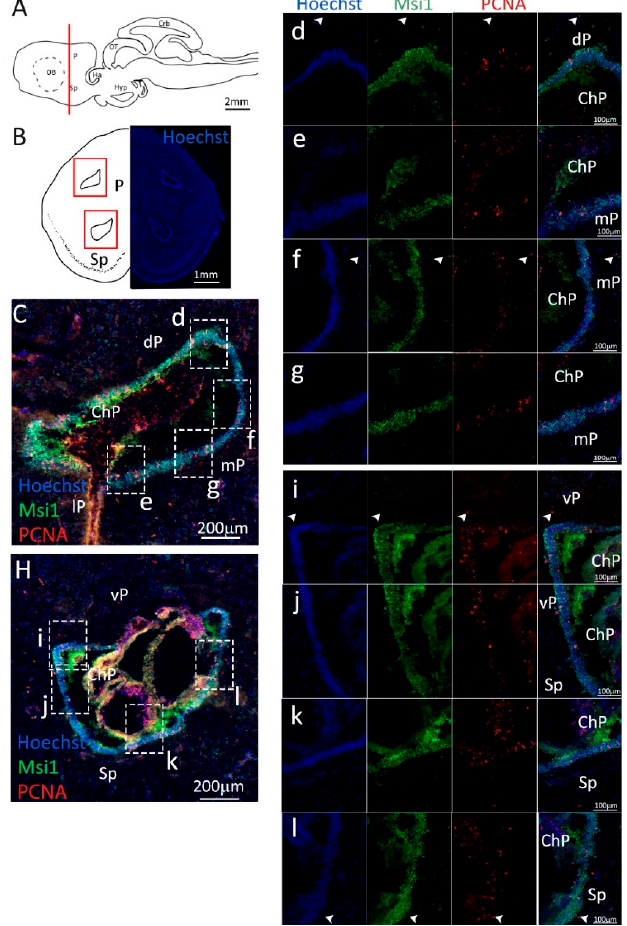
Figure 6. Localization of PCNA (red) and Msi1 (green) positive cells in the posterior telencephalon of S. canicula . ( A ) Sagittal representation of S. canicula brain. The red line indicates the rostro-caudal localization of the section represented in the panel. ( B ) Coronal map of the posterior telencephalon. On the right, a real coronal section is stained with Hoechst 33342 to show nuclei distribution; on the left, a cartoon is drawn to indicate anatomical references. Red rectangle identifies the general area from which images are taken. ( C ) Dorsal ventricle of the posterior telencephalon. This part of the ventricle is formed by dP, mP, and lP regions of the brain. Progenitor cells (Msi1 + , green) are localized around the ventricular wall. ( d ) Magnification of the neurogenic niche localized in the dP. White arrowheads indicate PCNA + /Msi1 − cells. ( e – g ) Magnification of the neurogenic niche localized in the mP. White arrowheads indicate PCNA + /S100 β − cells. ( H ) Ventral ventricle of the posterior telencephalon. This part of the ventricle is formed by vP and Sp regions of the brain. ( i , j ) Magnification of the neurogenic niche localized in the vP. White arrowheads indicate PCNA + /Msi1 − cells. ( k , l ) Magnification of the neurogenic niche localized in the Sp. White arrowheads indicate PCNA + /S100 β − cells. Abbreviations: P: pallium, Sp: subpallium, dP: dorsal pallium, mP: medial pallium, lP: lateral pallium, vP: ventral pallium, ChP: choroid